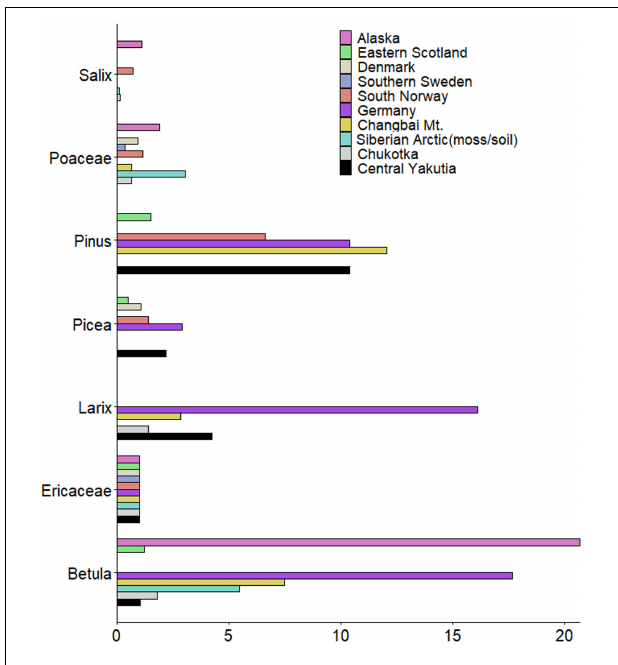
FIGURE 8 | Relative pollen productivity (RPP) estimates of seven selected taxa ( Alnus and Cyperaceae were excluded because of high standard deviations) compared to RPPs from other studies (Northern Finland and lake samples from Siberian Arctic were excluded as